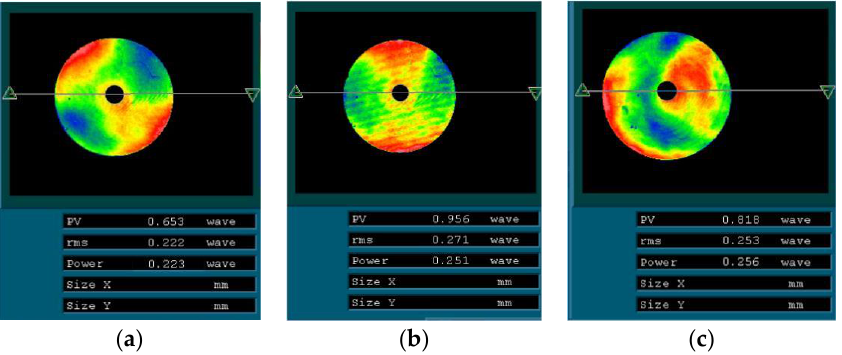
Figure 16. The detection results of each field of view in the maladjusted state: ( a ) F (0,0), 0.222 𝜆 ( b ) F (0,−0.1), 0.271 𝜆 and ( c ) F (0,0.1) 0.253 𝜆 .